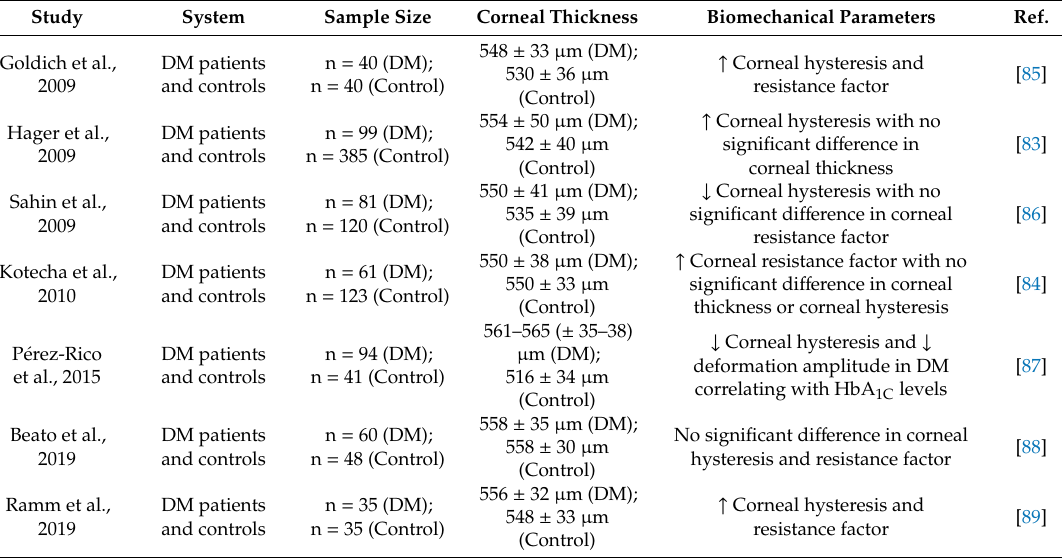
Table 1. E ff ects of DM on corneal thickness and biomechanical parameters in human patients. Sample